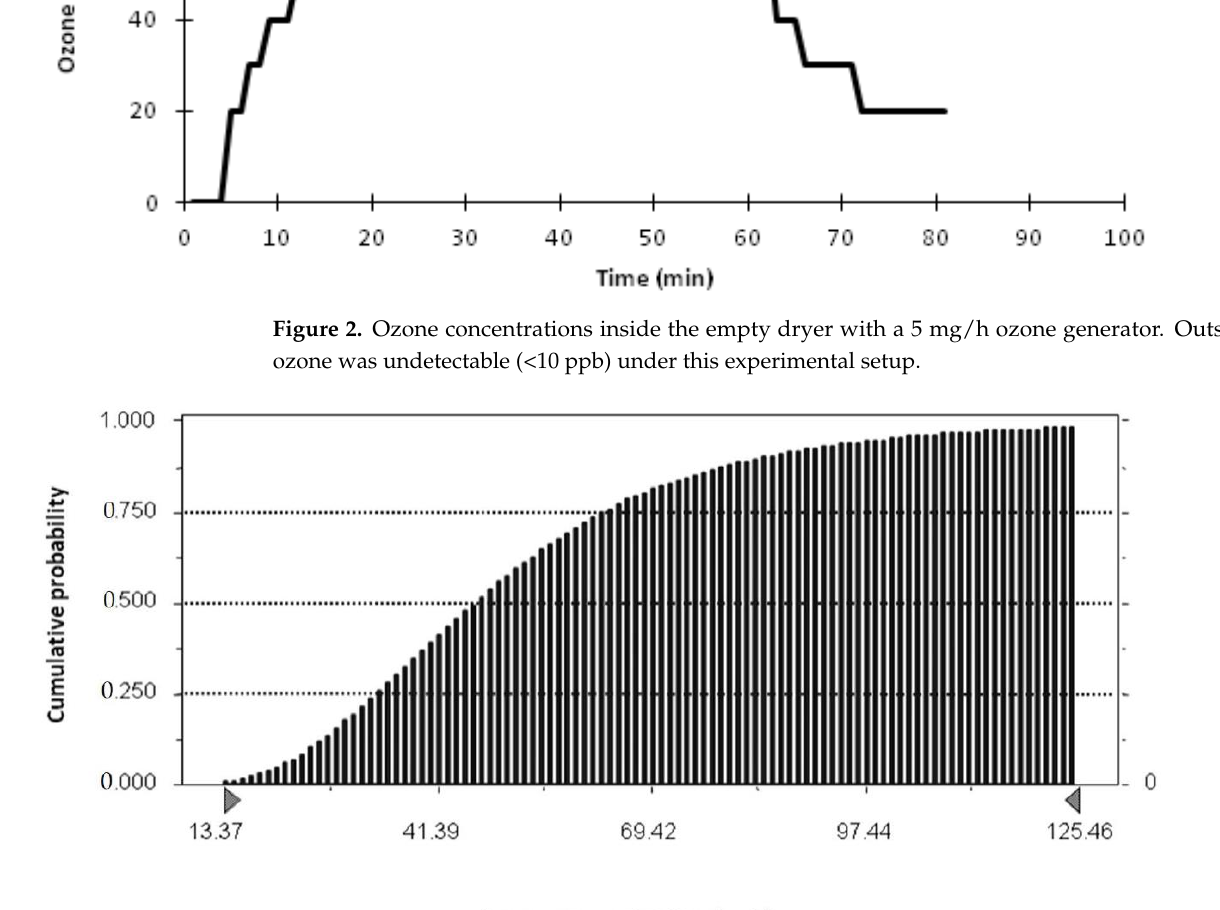
Figure 2. Ozone concentrations inside the empty dryer with a 5 mg/h ozone generator. Outside ozone was undetectable (<10 ppb) under this experimental setup.